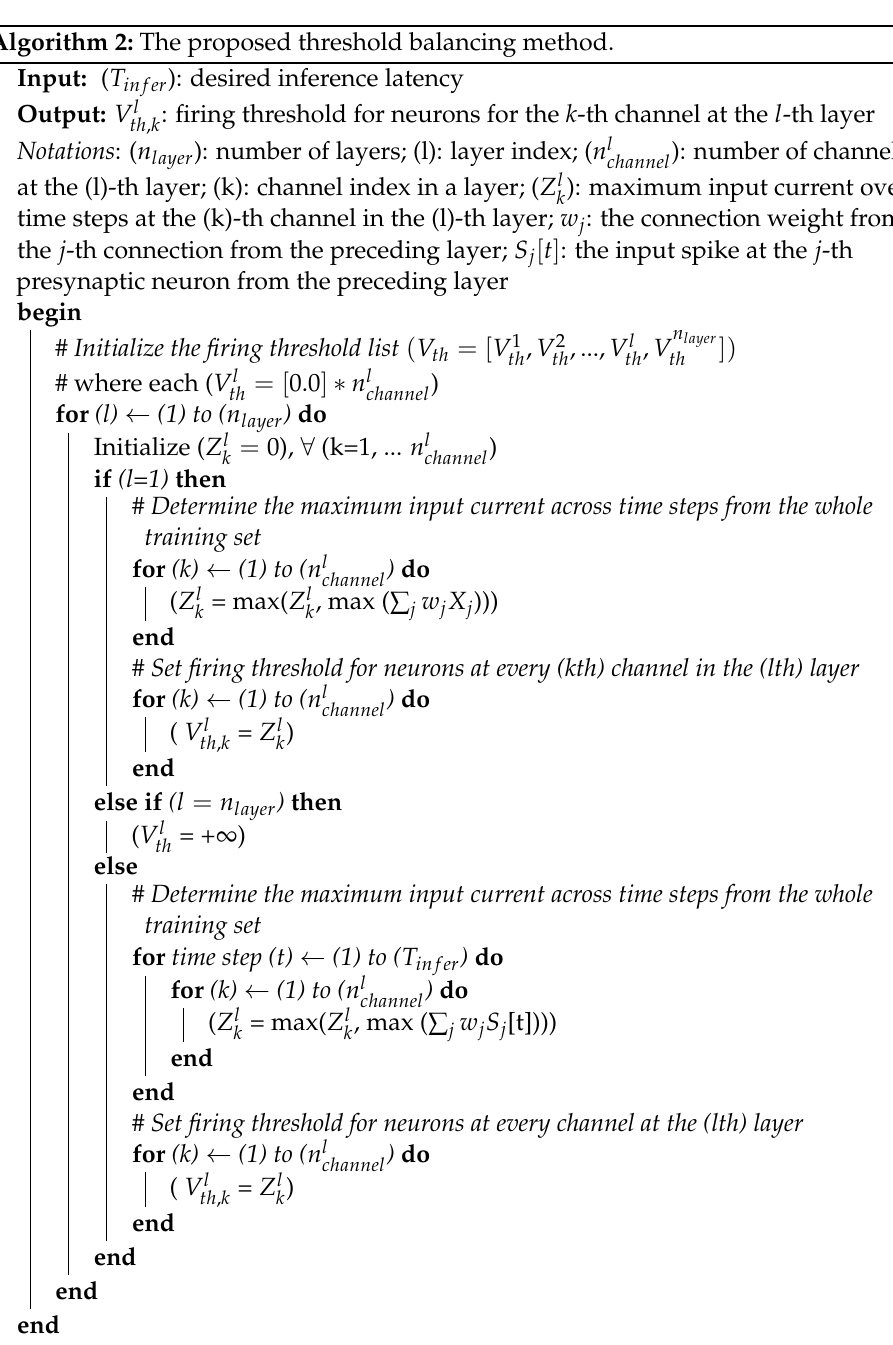
Algorithm 2: The proposed threshold balancing